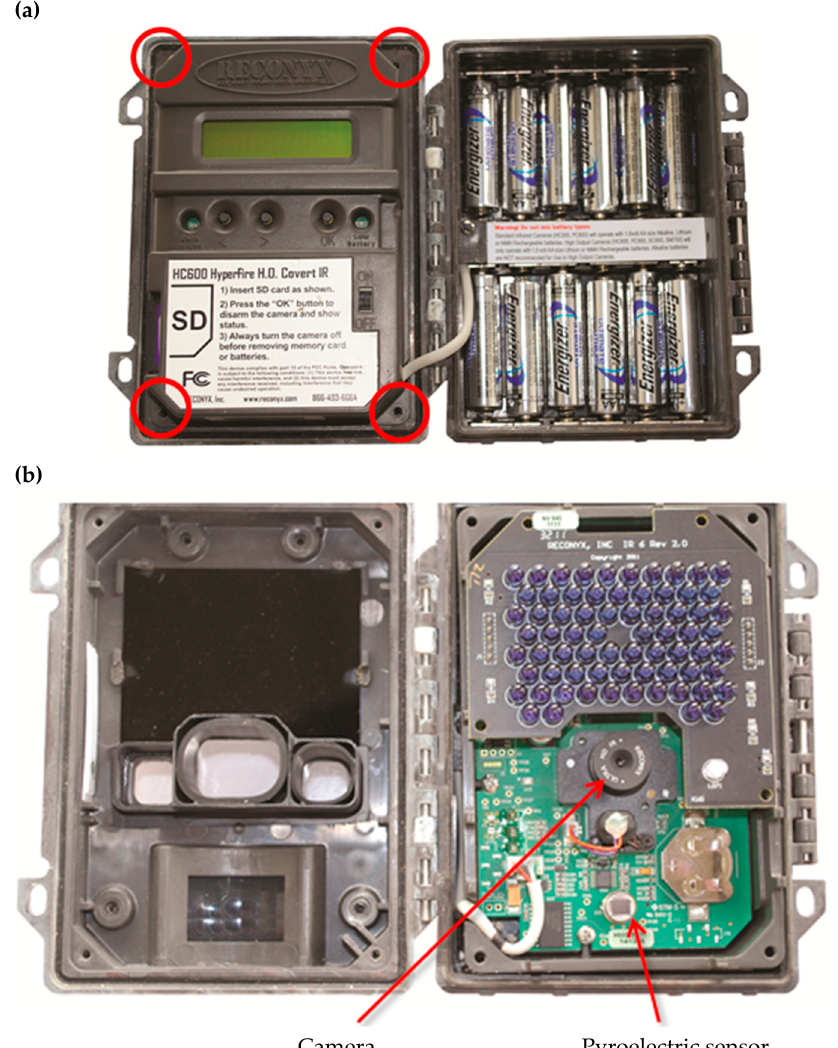
Figure 8. By removing the four screws highlighted in image ( a ), internal components ( b ) of the Reconyx PC900 and Reconyx HC600 camera-trap can be accessed.